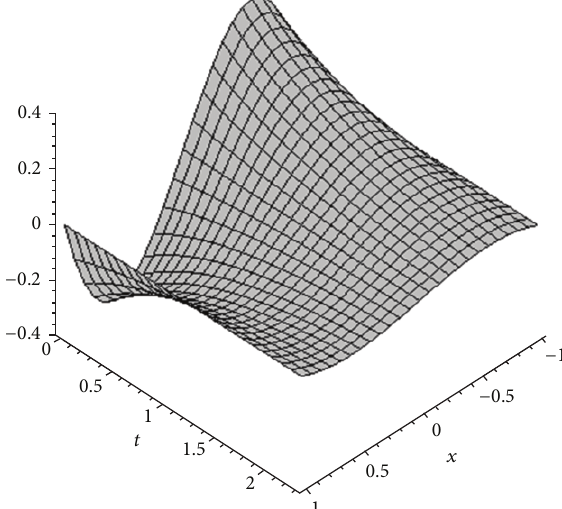
Figure 3: The graphic of the function 𝑢 2 (𝑡,𝑥) in the test problem (32).